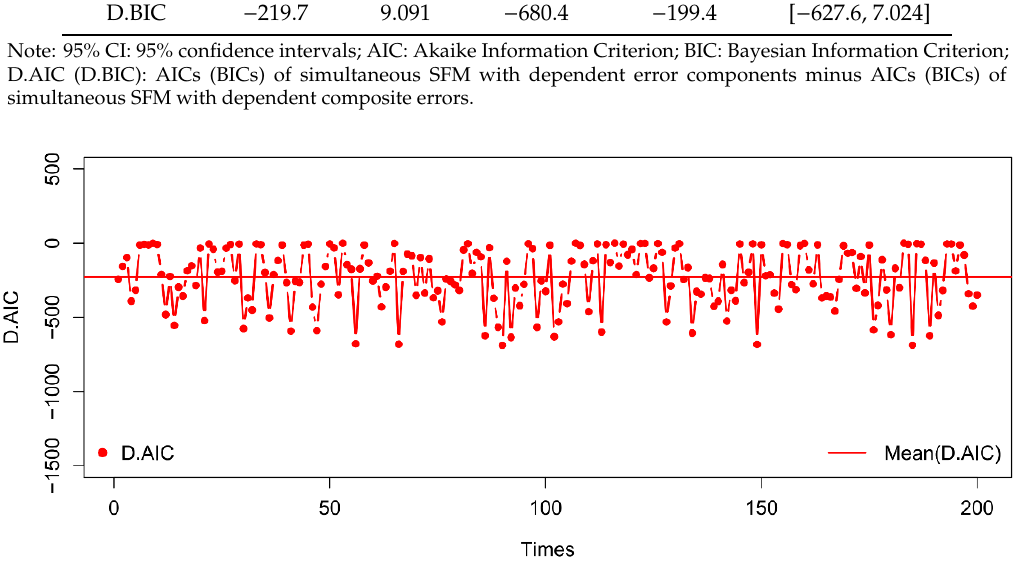
Figure 2. Differences between AICs of two copula-based simultaneous SFMs. Note: D.AIC: AICs of simultaneous SFM with dependent error components minus AICs of simultaneous SFM with dependent composite errors.